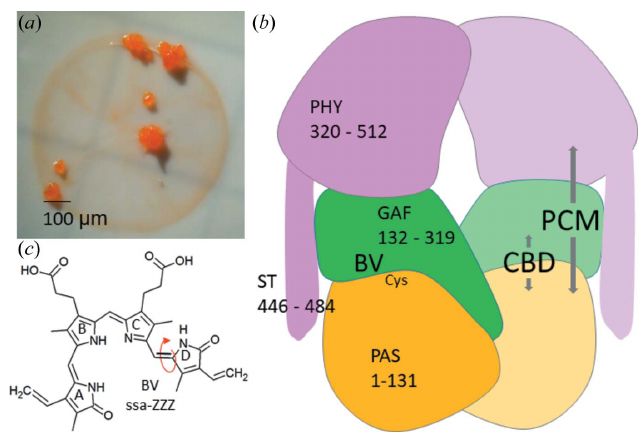
Figure 1 Myxobacterial fruiting bodies, and the architecture of